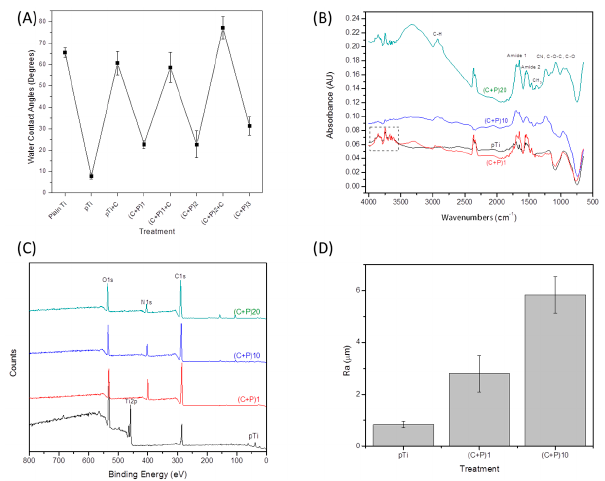
Figure 1. Physical and Chemical Properties of the layer-by-layer (LbL) coatings. ( A ) Water contact angles up to three bi-layers; ( B ) Diffusive reflectance Fourier-transfor infrared spectroscopy (DRIFTS) spectra; ( C ) X-ray photoelectron spectroscopy (XPS) surveys; and ( D ) values of average roughness ( R a ) calculated from Atomic Force Microscopy (AFM) imaging of Ti surfaces (pTi or plasma) and Ti coated with one bilayer ((C + P) 1 ), 10 bi-layers ((C + P) 10 ), and 20 bi-layers ((C + P) 20 ).